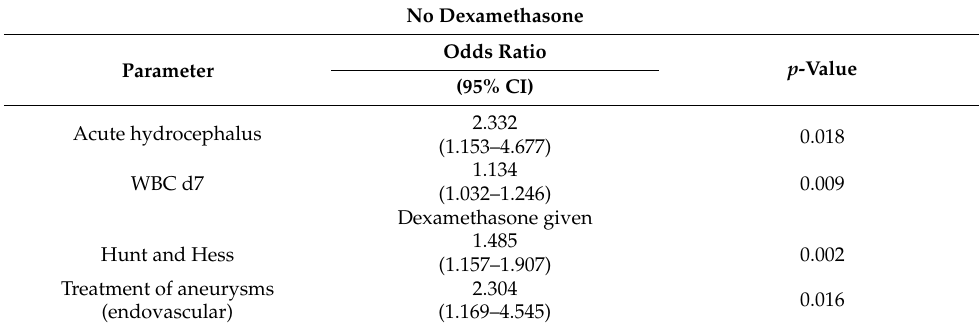
Table 3. Multivariate analysis for the development of delayed cerebral ischemia (significant